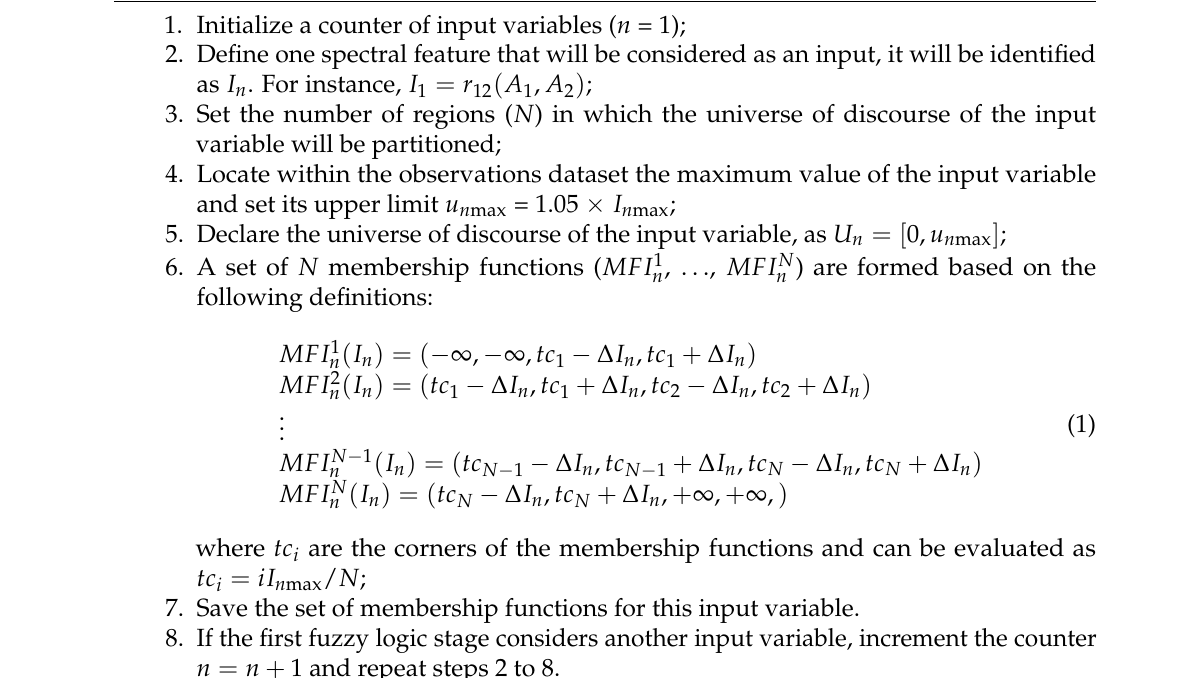
Algorithm 1 Procedure for building the membership functions to fuzzificate the inputs variables of